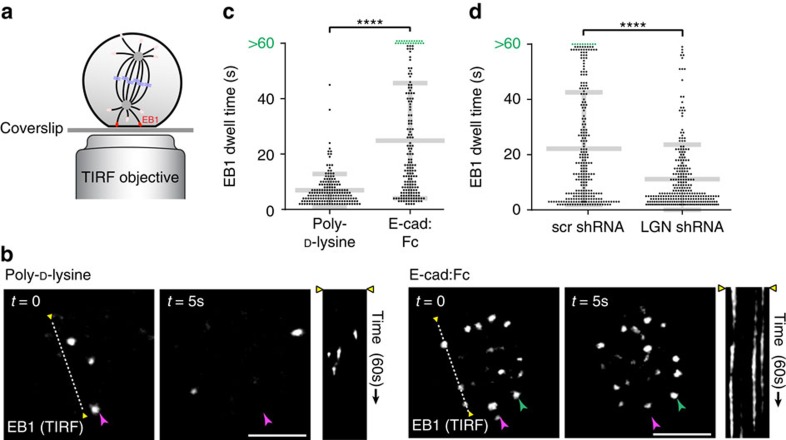
E-cadherin adhesions stabilize cortical astral microtubule associations.(a,b) TIRF microscopy imaging of mRFP-EB1-marked astral microtubules at the basal membrane of MDCK cells adhering to poly-D-lysine or E-cad:Fc-coated surfaces. The kymograph shows the duration of basal mRFP-EB1 events in a 60 s period along the indicated dotted line. Purple and green arrowheads indicate dynamic (<5 s duration) and stable (>5 s duration) EB1 puncta, respectively. (c) Quantification of dwell times of EB1 puncta at the basal membrane of mitotic MDCK cells adhering to poly-D-lysine or E-cad:Fc-coated surfaces (n=14 cells). (d) Quantification of the dwell times of EB1 puncta at the basal membrane of mitotic MDCK cells, expressing scrambled control (scr) or LGN shRNA, adhering to E-cad:Fc-coated surfaces (n=11 cells). Scale bars, 5 μm. Quantified data were pooled from three independent experiments; grey bars show mean±s.d. ****P<0.0001 using Mann–Whitney test.